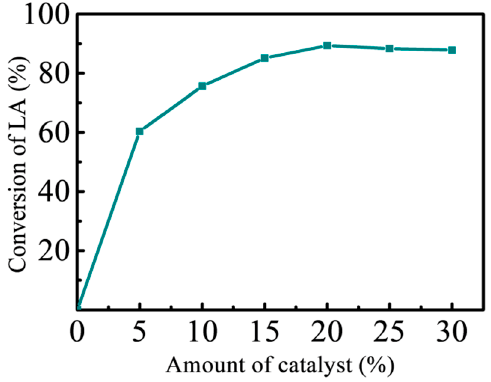
Figure 8. Effect of catalyst amount on conversion of levulinic acid operated at reaction temperature: 120 °C, reaction time: 4 h, m catalyst : m acid : 5%, 10%, 15%, 20%, 25%, and 30%.